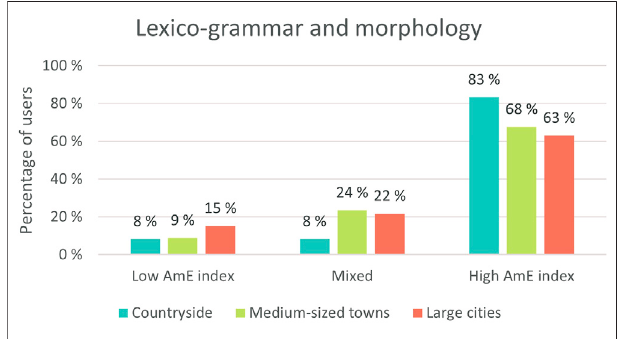
FIGURE 11 | Lexico-grammatical and morphological variation in idiolects divided based on geographical